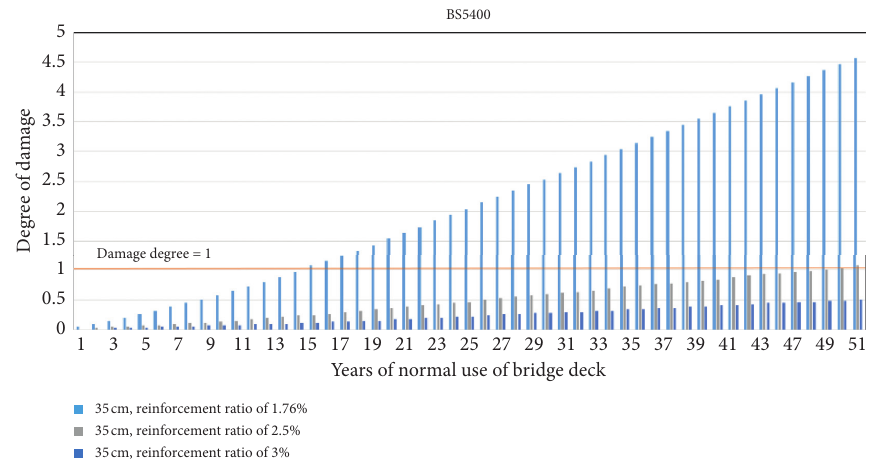
Figure 20: Fatigue damage of bridge-deck reinforcement under three reinforcement ratios with a slab thickness of